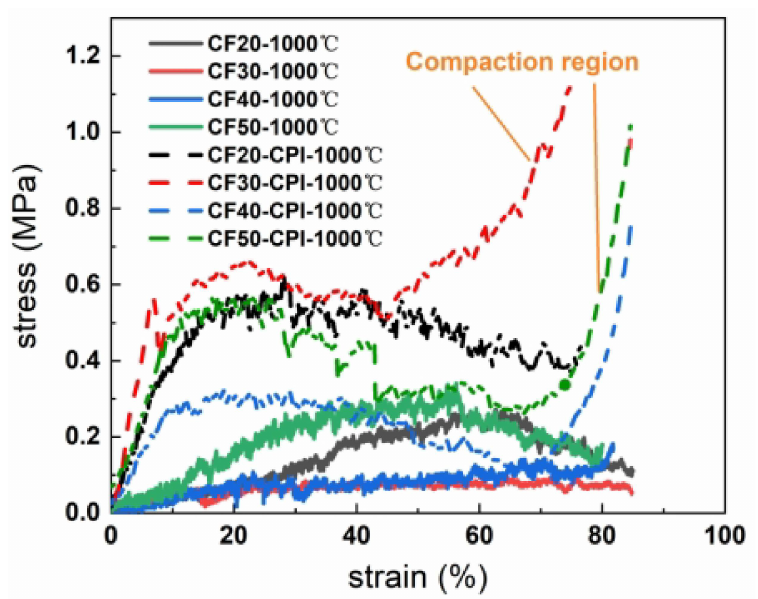
Figure 11. Compressive strain–stress curves of CF-1000 ◦ C and CF-CPI-1000 ◦ C.